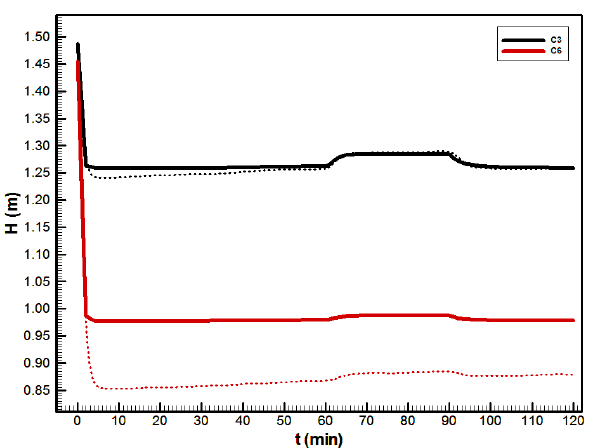
Figure 16. Hydraulic head: Experimental (dashed line) and numerical (solid line) results for the two most dynamic piezometers that were closest to the conduits.